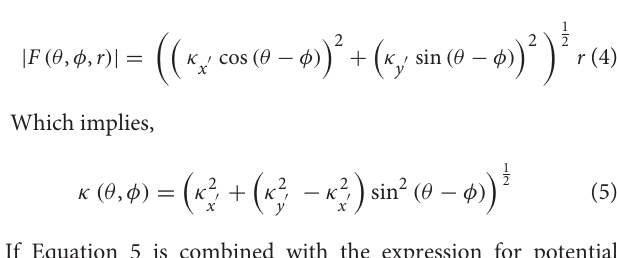
FIGURE 4 | Iso-potential lines over which k B T = 1 form as that shown in Figure 1 (red) and a trap with the same average value of κ but isotropic